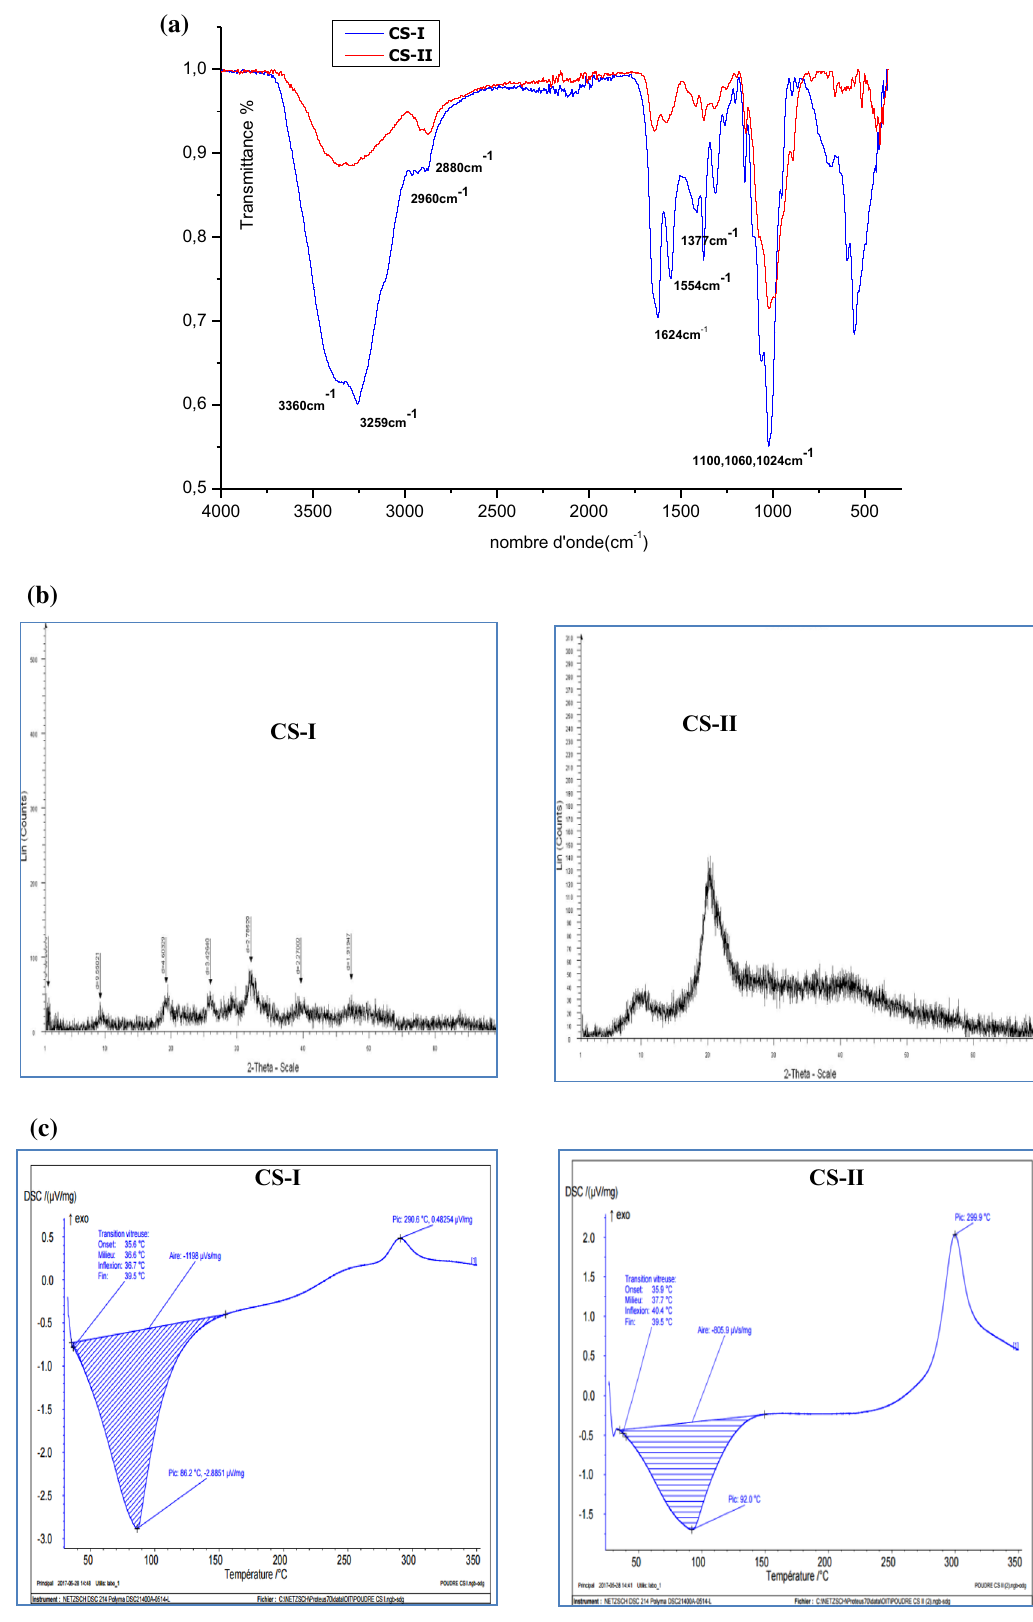
Fig. 4 Characterization of CS-I and CS-II a FTIR Spectra, b X-ray diffractogram, c DSC